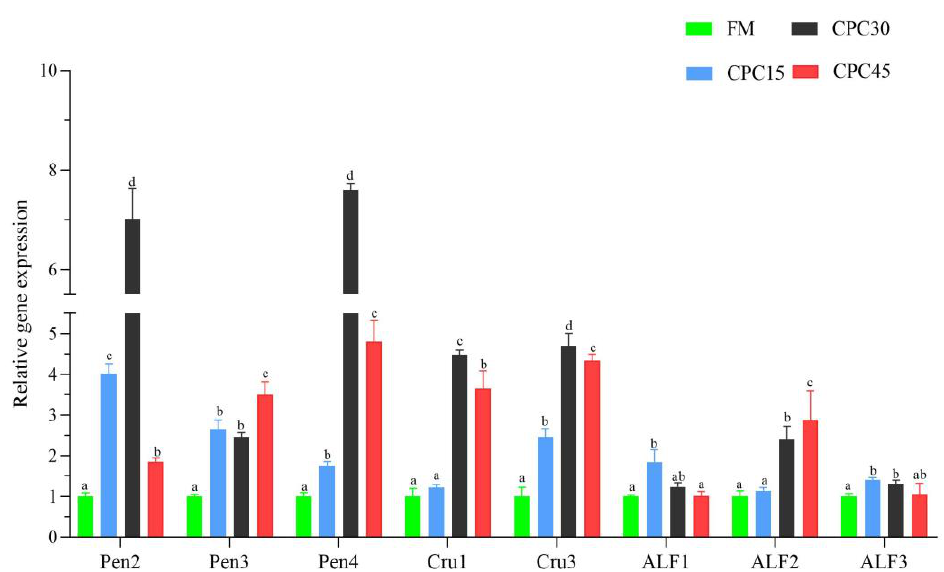
Figure 9. The expression of antimicrobial peptide genes in L. vannamei by different levels of CPC- substituted fishmeal. Different superscript letters indicate significant differences exist among treat- ments ( p < 0.05).